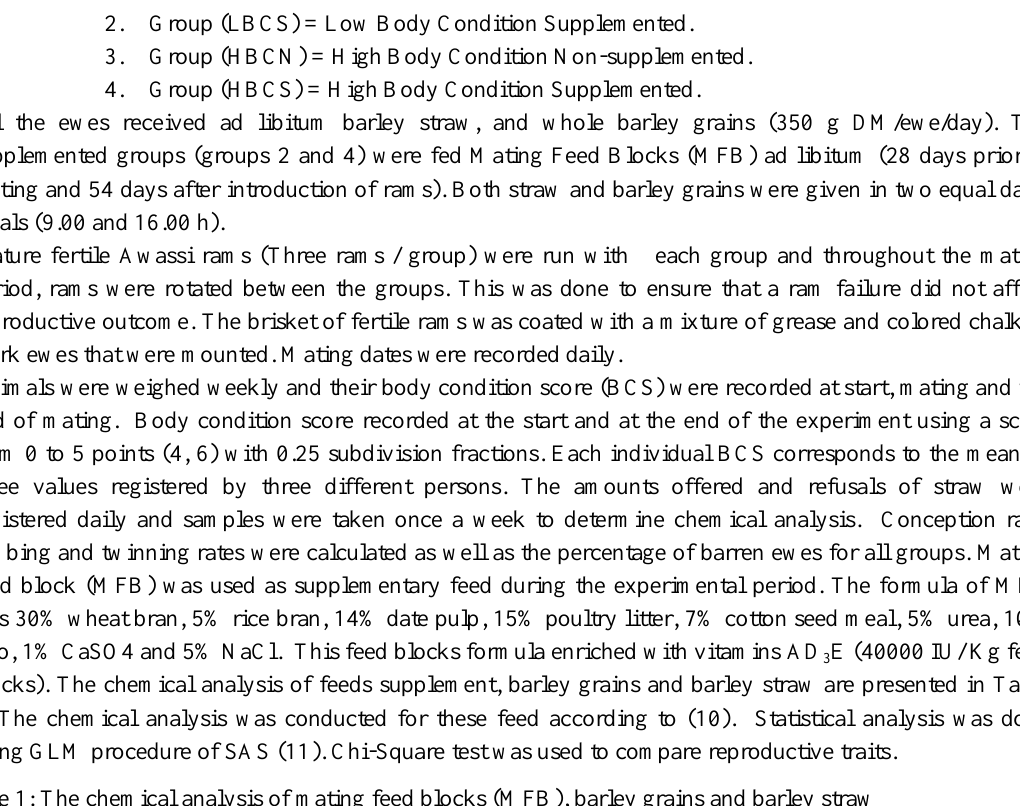
Table 1: The chemical analysis of mating feed blocks (MFB), barley grains and barley straw MFB Barley grain Barley straw Dry matter 95.32 91.80 93.54 Crude protein 18.15 10.80 3.94 Ether extract 1.39 1.70 0.73 Crude fiber 13.79 6.70 39.14 Ash 23.41 2.70 12.65 Estimated ME (MJ/kg DM) 8.5 12.5 5.5